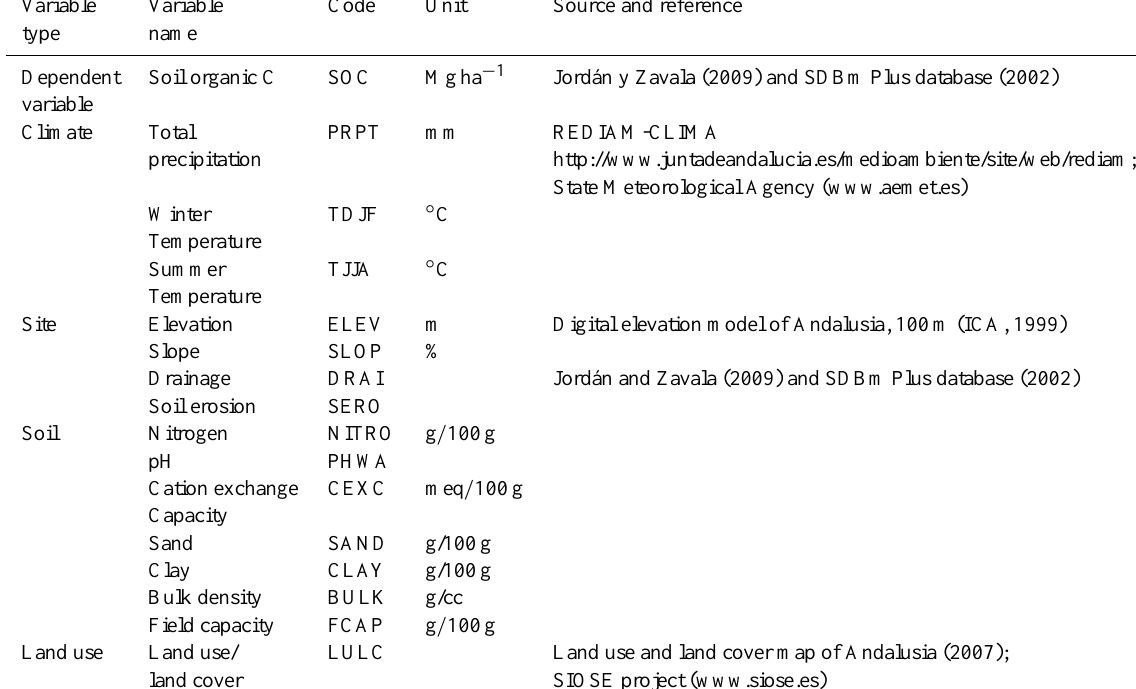
Table 1. CarboSOIL model input variables, units and